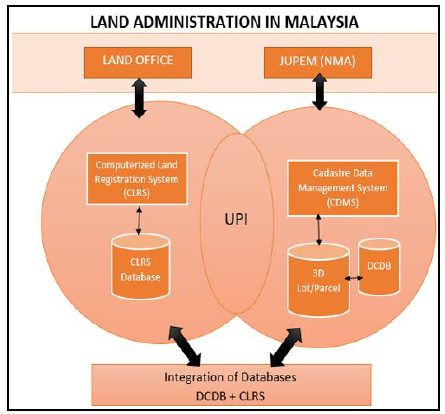
Figure 10. Integrating system using UPI